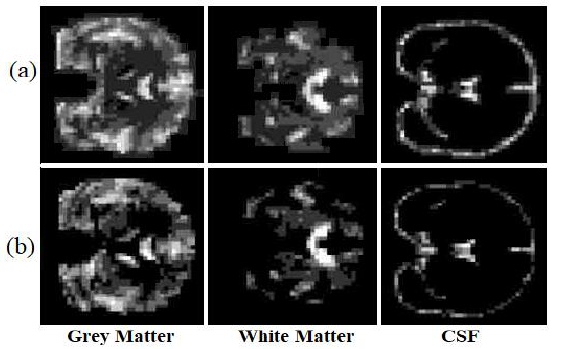
Figure 7. The ground truth ( a ) and the synthetic T1 weighted MRI ( b ).